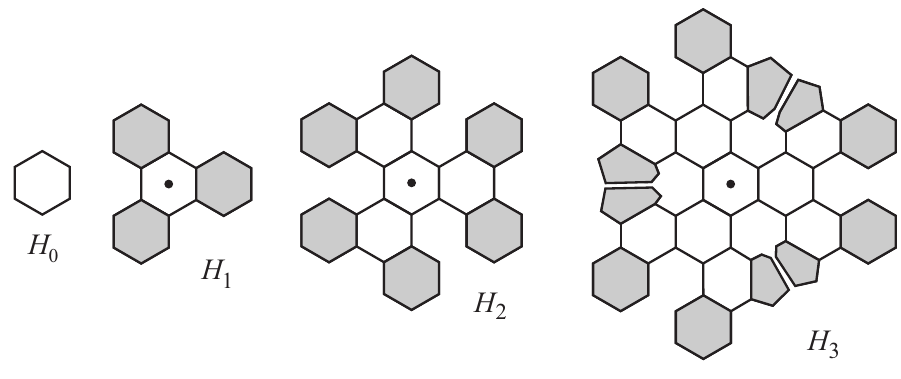
Figure 5. Benzenoid graphs H k , k ≥ 0.